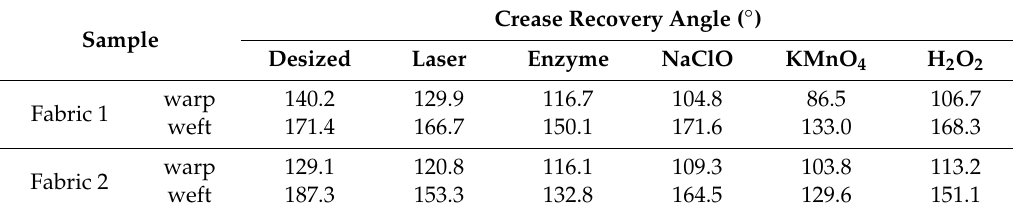
Table 8. Crease recovery angle of denim fabrics with di ff erent bleaching types.